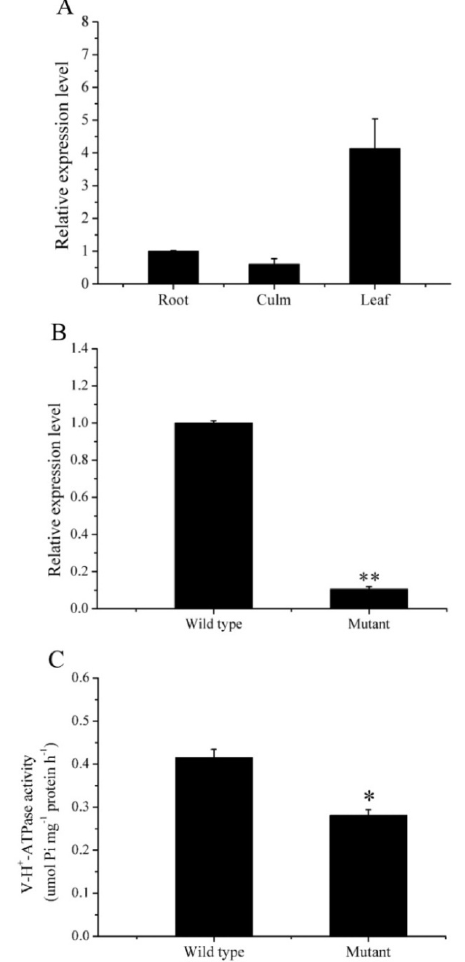
Figure 3. Analyses of OsVHA-A expression and V-H + -ATPase activity in various tissues and genotypes. ( A ) Expression levels of OsVHA-A in root, culm, and leaf; and ( B ) genotype-dependent expression levels of OsVHA-A in the flag leaves at the heading stage. ( C ) V-H + -ATPase activities in the flag leaves of the two rice genotypes at the heading stage; vertical bars represent standard errors with three independent biological replications. * and ** represent significant differences at 0.05 and 0.01 probability levels, respectively.